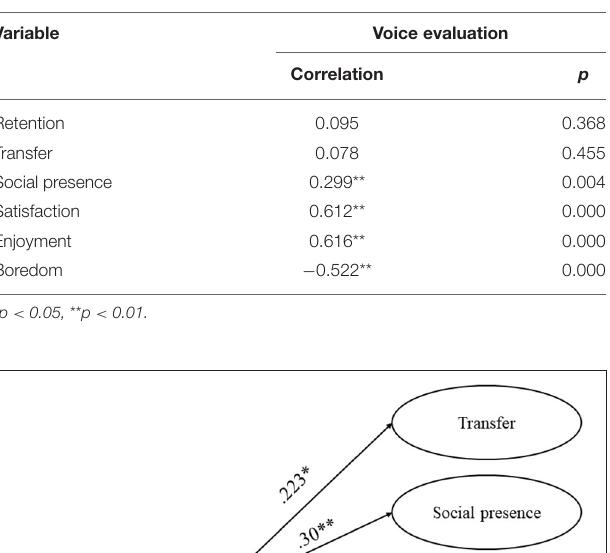
TABLE 4 | Correlation coefficients of each variable and voice evaluation.